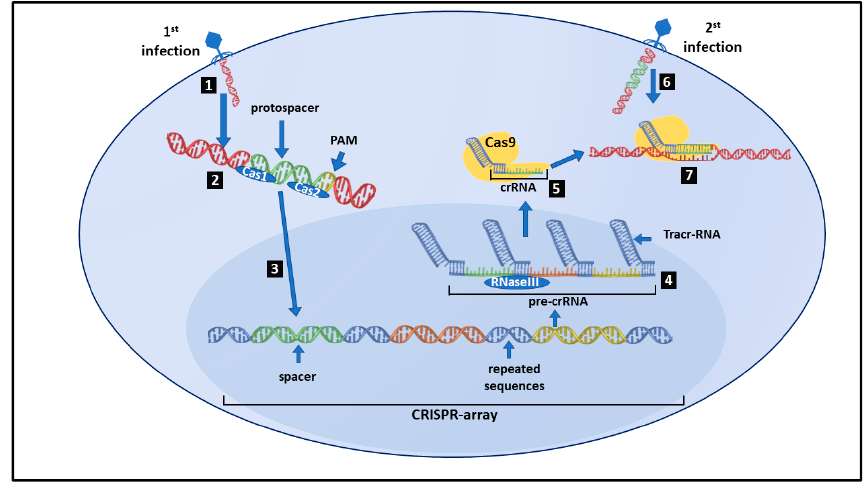
Figure 1. CRISPR/Cas system in bacteria. When a bacteriophage infects a bacterium for the first time (1), its DNA is scanned by Caspase proteins 1 and 2, which recognize specific viral sequences located near the protospacer adjacent motif (PAM) (2). Once a PAM is recognized, DNA is cleaved upstream the PAM sequence and protospacer is integrated into the CRISPR-array, which includes hexogen DNA (spacers) intercalated between bacterial DNA palindromic repeated sequences (3). The CRISPR-array transcribed by bacterium (pre-crRNA) complements with trans-activating RNA (tracr-RNA) encoded in proximity of the Cas genes (4). The RNaseIII recognizes this complex and cleaves it into smaller RNAs named CRISPR-RNA (crRNA). The crRNA is bound by Caspase9 (Cas9) forming the ribonucleoprotein complex named CRISPR/Cas9 I (5). Once the same bacteriophage tries to infect the host cell for the second time (6), the CRISPR/Cas9 complex recognizes PAM and cleaves the viral DNA (7). This approach was achieved by Tian et al. in order to disclose the role of UGT1A9 , a gene encoding a UDP-glucuronosyltransferase enzyme, in bisphenol-induced NAFLD [21]. They observed limited liver injuries in UGT1A − / − mice when exposed to bisphenol, compared to wild-type mice. This result displayed the critical role of UGT1A9 in bisphenol-mediated mitochondrial dyshomeostasis and NAFLD pathogenesis [21]. Recent advances made CRISPR technology a powerful tool able to target multiple genes simultaneously and study their combinatory effects [22,23]. PNPLA3 , TM6SF2 , and MBOAT7 genes are involved in the pathogenesis and progression of NAFLD [24]. In detail, variants rs738409 in PNPLA3 , rs641738 in MBOAT7 , and rs58542926 in TM6SF2 are associated with increased triglyceride production, accumulation of very low-density lipoprotein (VLDL) and triglycerides and increased risk of developing cirrhosis, respectively [25]. In order to assess the association between the above SNPs and the severity of liver diseases, Longo et al. silenced HepG2 cells for rs738409 PNPLA3 , rs641738 MBOAT7 , and rs58542926 TM6SF2 using the CRISPR/Cas9 technology [26]. Results showed that MBOAT7 − / − and TM6SF2 − / − models inhibited the release of both Apolipoprotein B and TAG-rich lipoproteins and reduced the risk and severity of fatty liver diseases [26]. Independent research also reported the effectiveness of CRISPR/Cas genome editing technology in treating human diseases [27]. The treatment with CRISPR-Cas editing technology of patients suffering from transthyretin amyloidosis (ATTR) yielded very encouraging results [28]. The encapsulation of the CRISPR/Cas9 complex into lipid nanoparticles (LNP) corrected the transthyretin amyloid (ATTR) disease due to the over- expression of the transthyretin ( TTR ) gene. The LNP-encapsulated CRISPR was therefore inoculated intravenously and adsorbed by host cells, where the complex cuts away the TTR gene (Figure 2A). The large volume of blood flowing in the liver favors the accumulation of the gene therapy particles directly in the liver hepatocytes through their fenestrated endothelium more rapidly than in organs with a continuous endothelium. In addition, the very slow overturn of hepatocytes provides limited dilution of gene therapy.